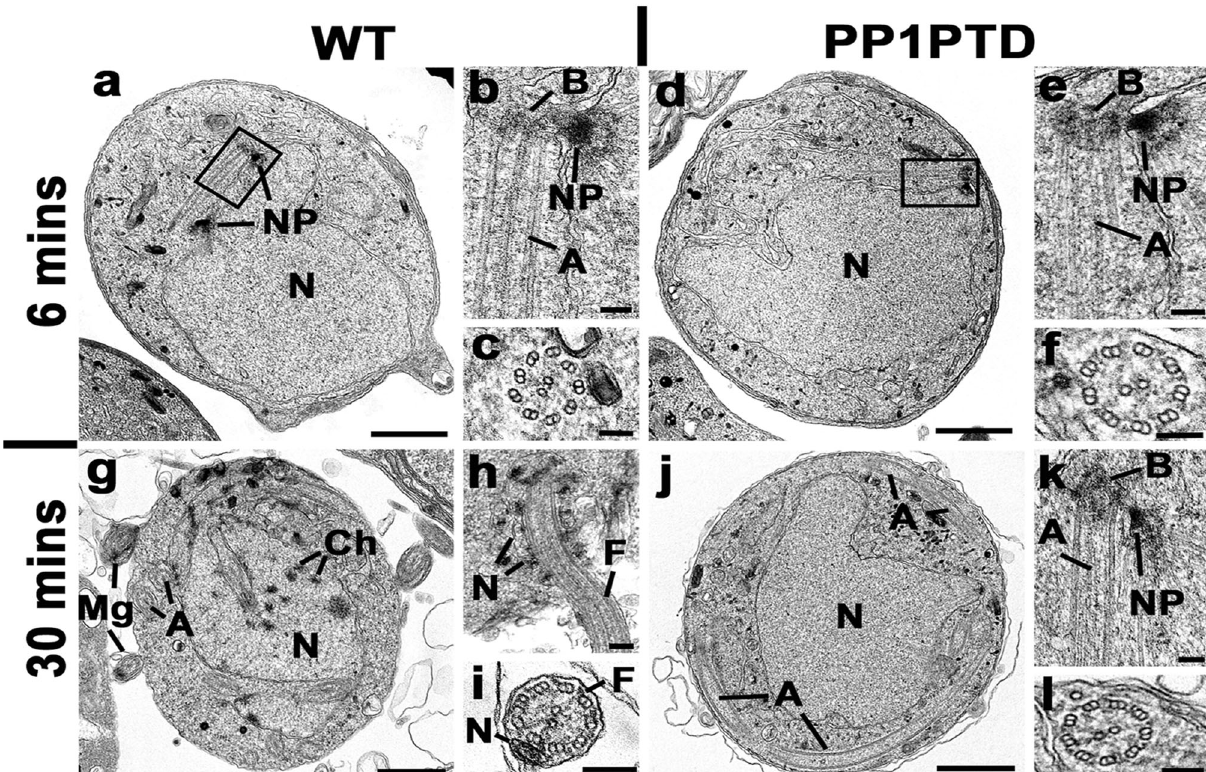
Fig. 5 Ultrastructure analysis of PP1PTD gametocytes shows defects in nuclear pole and axoneme assembly during male gametogony. Electron micrographs of WTGFP ( a – c , g – i ) and PP1PTD ( d – f , j – l ) male gametocytes at 6 min ( a – f ) and 30 min ( g – i ) post activation (pa). Scale bars represent 1 µ m ( a , d , g , j ) and 100 nm in all other micrographs. a Low power micrograph of a WTGFP male gametocyte with two nuclear poles (NP) associated with the nucleus (N). b Enlargement of the enclosed area showing the nuclear pole (NP) with adjacent basal body (B) and associated axoneme (A). c Cross section of an axoneme showing the 9 + 2 microtubule arrangement. d Low power micrograph of PP1PTD male gametocyte showing the central nucleus (N) with a nuclear pole and associated basal body (enclosed area). e Enlargement of the enclosed area showing the nuclear pole (NP) with adjacent basal body (B) and associated axoneme (A). f Cross section through an axoneme showing the 9 + 2 arrangement of microtubules. g Low power micrograph of a 30-min pa WTGFP male gametocyte showing the nucleus with areas of condensed chromatin. Note the cross sectioned free male gametes (Mg). A – axoneme. h Periphery of a male gametocyte undergoing ex fl agellation with the nucleus (N) associated with fl agellum (F) protruding from the surface. i Cross section of a free male gamete showing the 9 + 2 microtubules of the fl agellum (F) and electron dense nucleus (N). j Low power micrograph of a PP1PTD male gametocyte at 30 min pa showing the central nucleus (N) with a nuclear pole and an increased number of axoneme pro fi les (A) within the cytoplasm. k Detail of the periphery of a nucleus showing the nuclear pole (NP), basal body (B) and associated axoneme (A). l Cross section of an axoneme showing the 9 + 2 microtubule